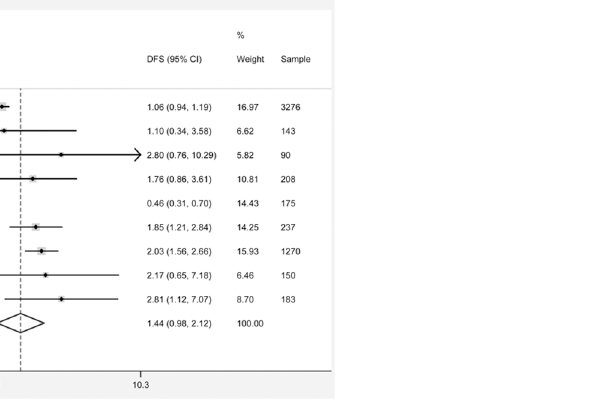
Fig 2. FOXP3 expression and DFS.